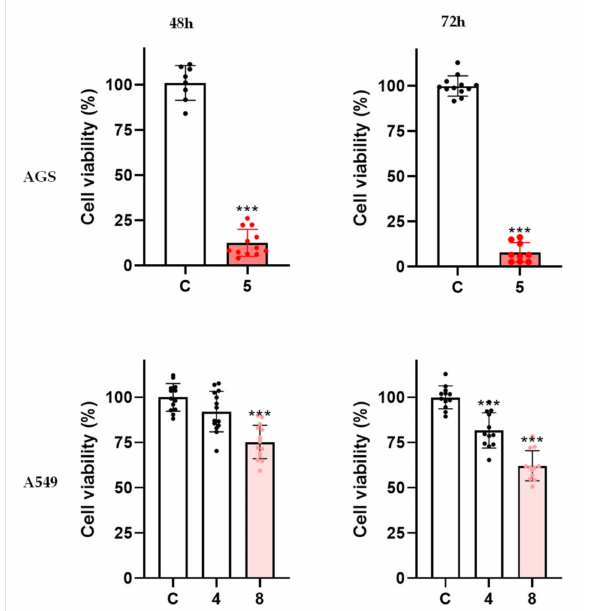
Figure 6. Viability of AGS cells exposed to molecule 5 (100 µ M) at 48 h/72 h and viability of A549 cells exposed to molecules 4 and 8 (100 µ M) at 48 h/72 h. The results correspond to the mean value for at least three independent experiments performed in triplicate. Each dot represents a single determination. C: control; *** p <